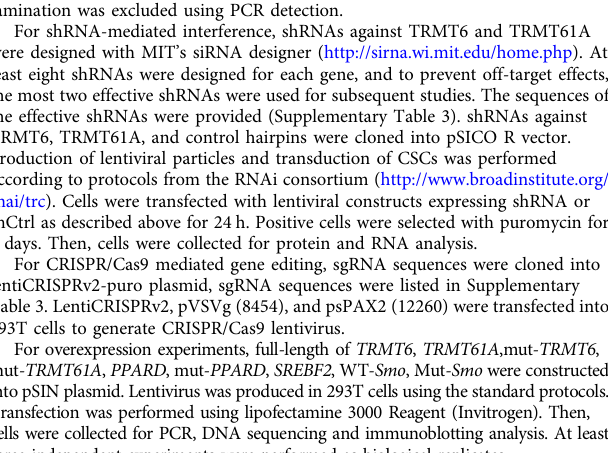
Table 3. LentiCRISPRv2, pVSVg (8454), and psPAX2 (12260) were transfected into 293T cells to generate CRISPR/Cas9